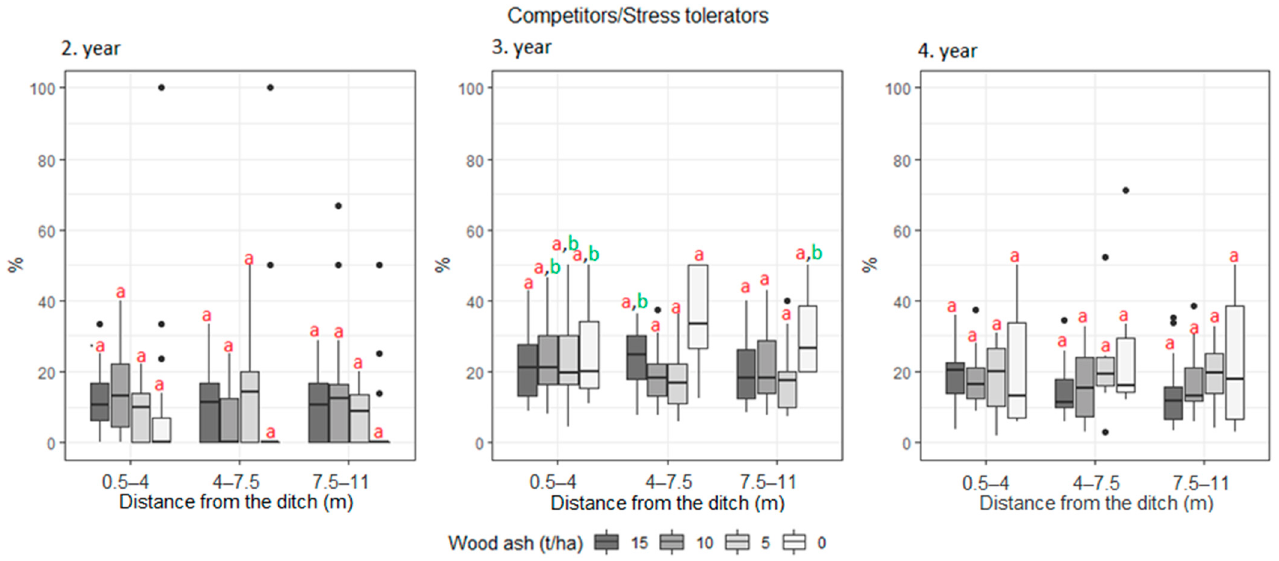
Figure A6. Relative cover of plants with competitor/stress tolerant universal adaptive strategy from the total vegetation cover, depending on the distance from the drainage ditch and the dose of wood-ash fertiliser. Different letters (a, b) indicate significant differences between groups, p < 0.05 according to the Tukey HSD test.